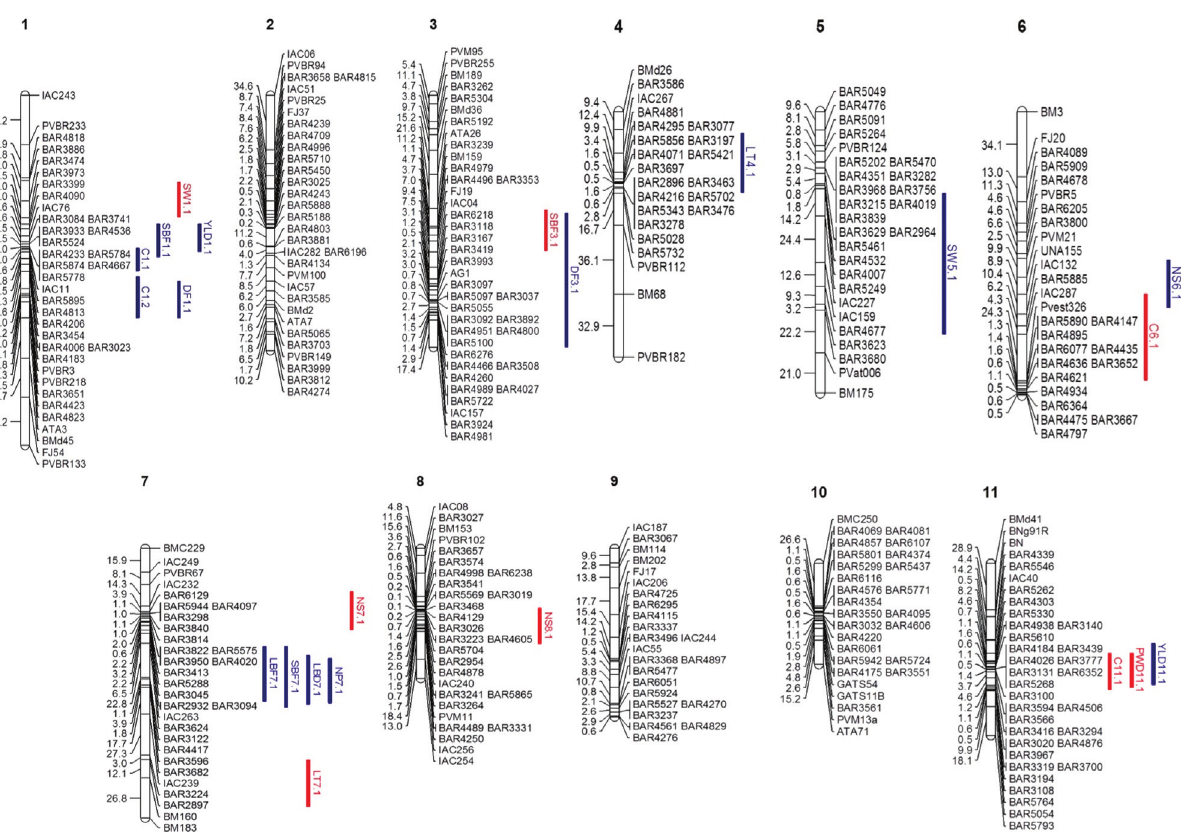
Figure 2 - Common bean linkage map constructed using the AND 277 x SEA 5 RIL population. The positions of the QTLs for drought (blue) and irri- gated treatments (red) are shown. Chromosomes were assigned based on the P. vulgaris L. genome (http://www.phytozome.net/).